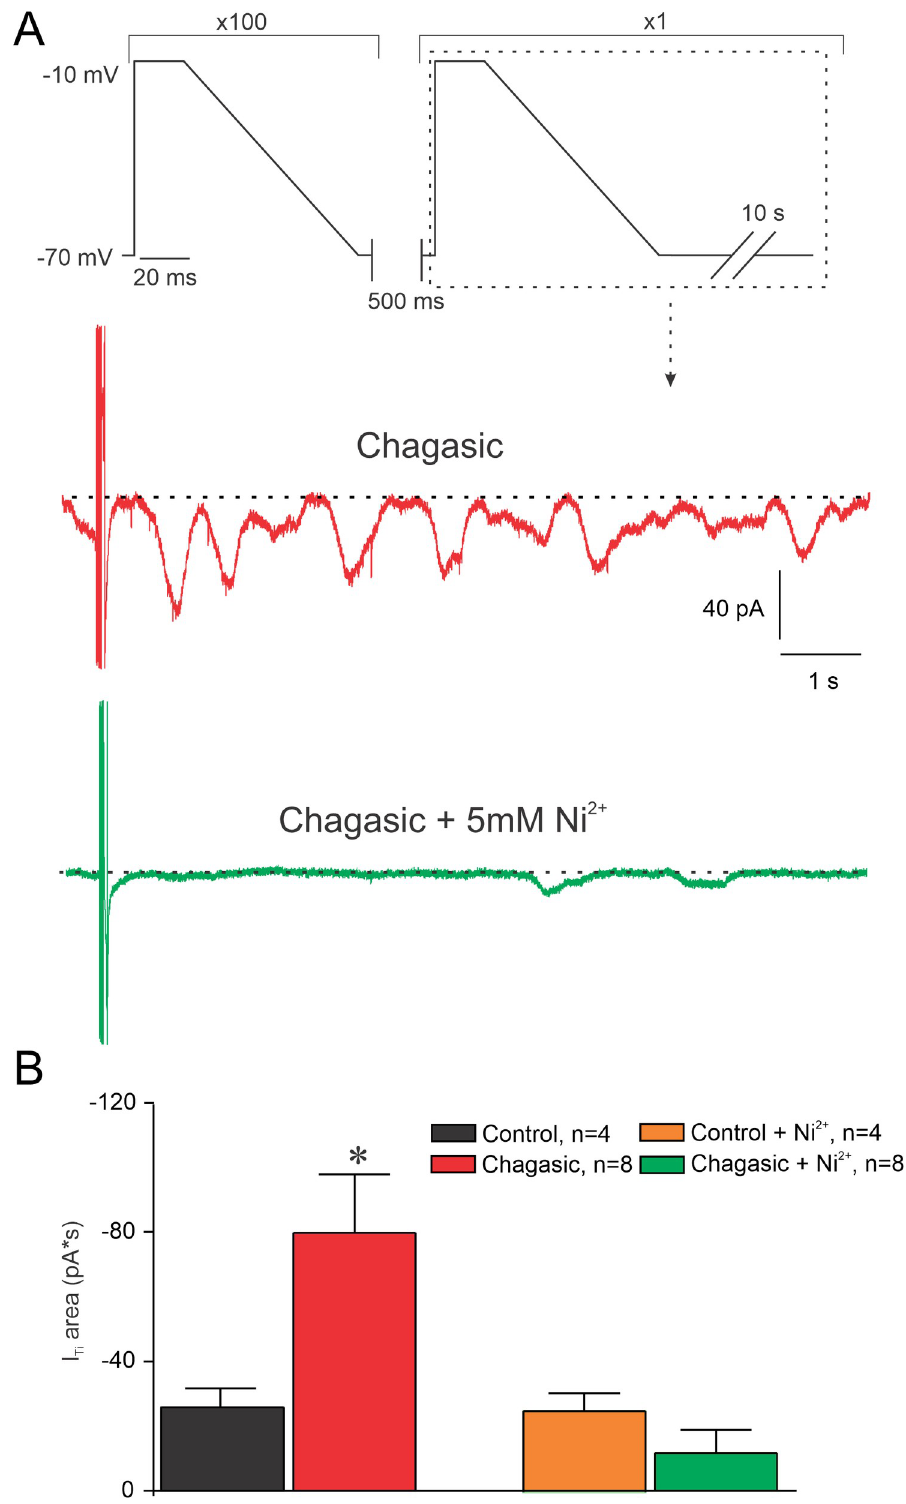
Fig 6. Ni 2+ attenuates transient inward current (I Ti ) in the chronic phase of experimental Chagas disease. The protocol is depicted at the top of the figure. (A) Current traces following 100 pre-conditioning pulses and a single 500 ms pause using long pulse, before (red) and after perfusion of 5 mM Ni 2+ (green traces). (B) Composite